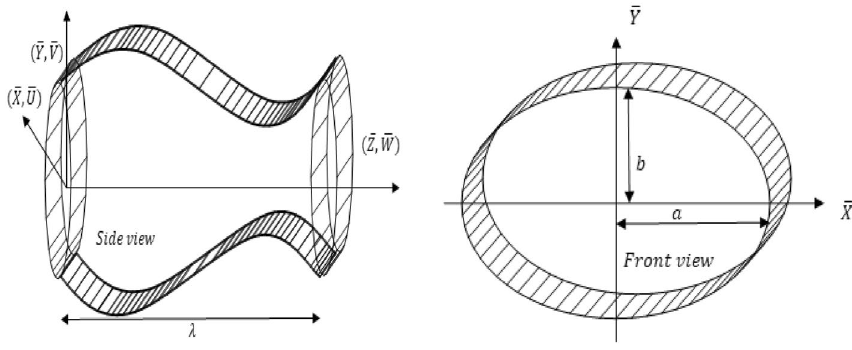
Figure 1. Geometry of Elliptic